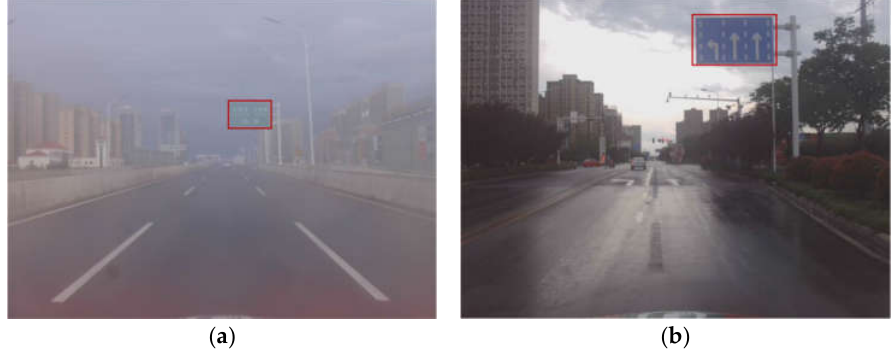
Figure 23. Test site on rainy day: ( a ) city expressway; ( b ) ordinary urban road.